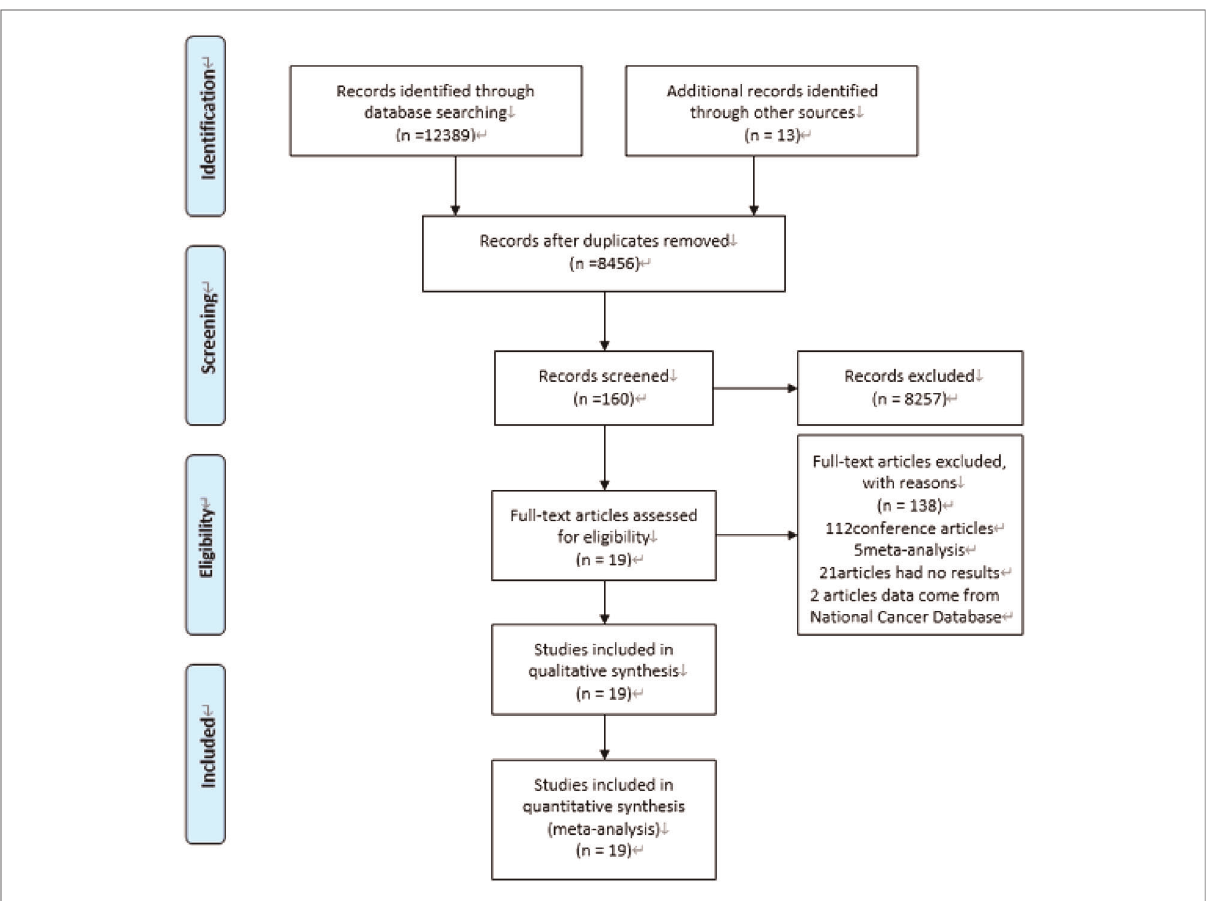
FIGURE 1 PRISMA fl owchart of search strategy and study